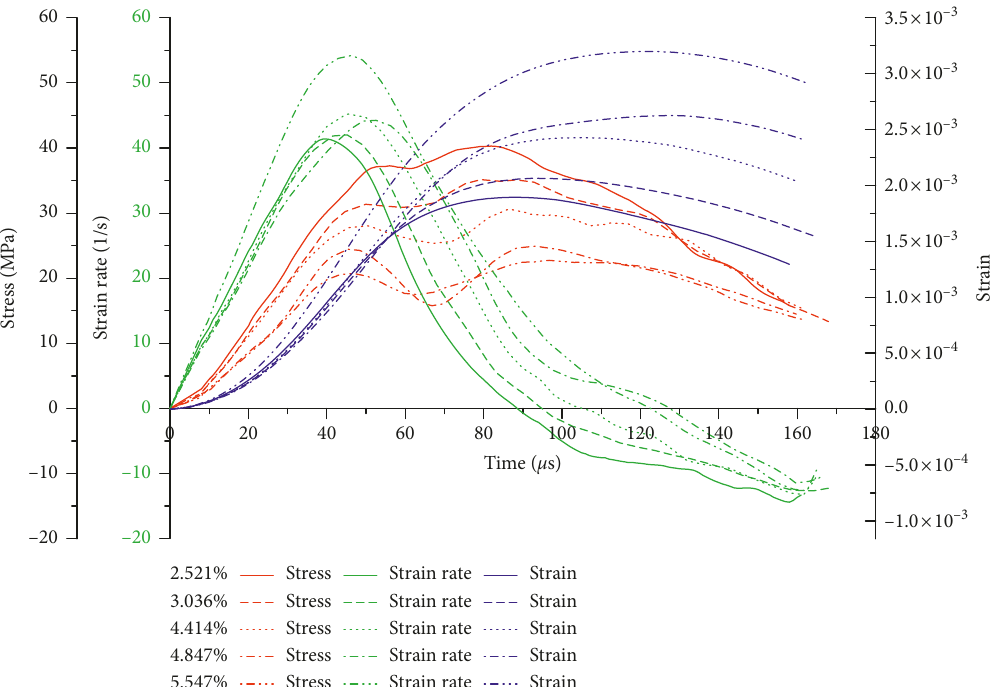
Figure 7: Time history curves of stress, strain, and strain rate of weakly weathered granites with different porosities under uniaxial impact pressure.